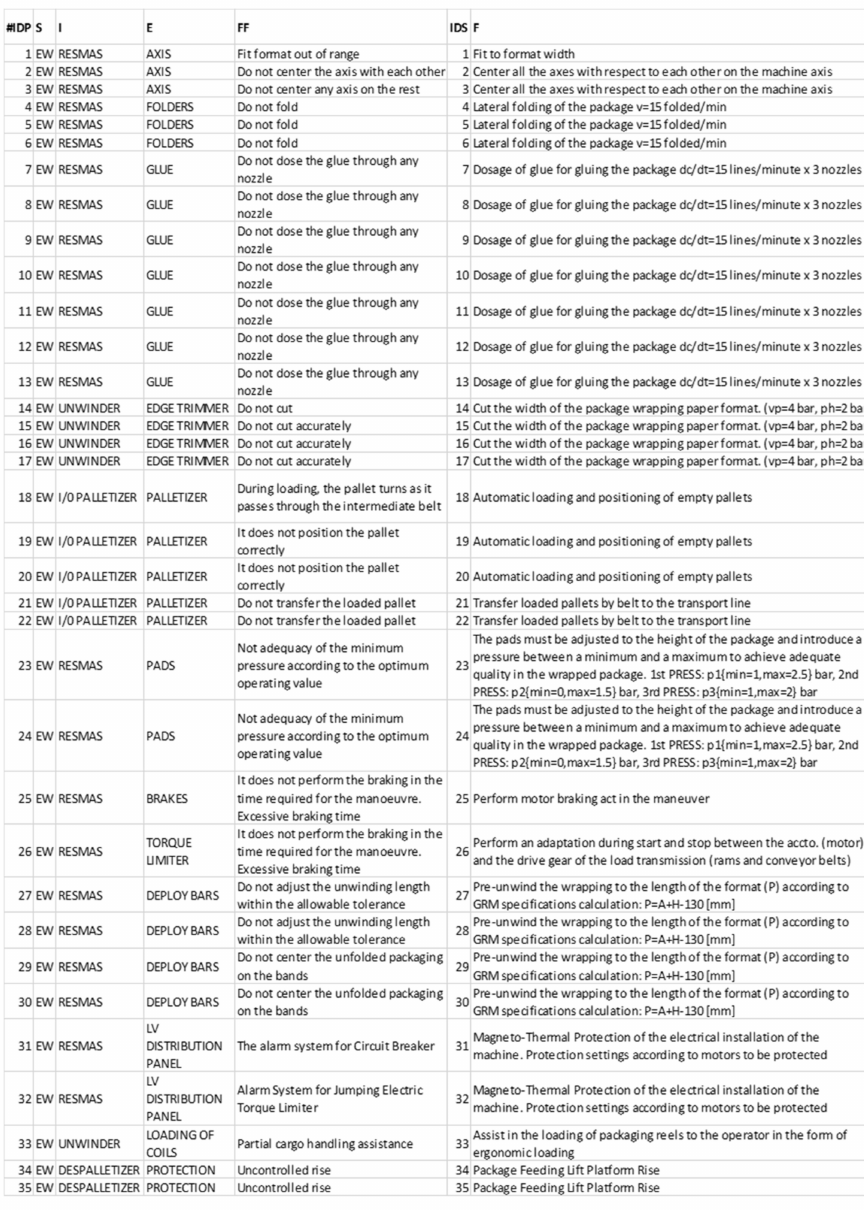
Figure 4. Records of the CSV file that make up the Case Base. Attributes {IDP}. Table 1. Attributes of the Case Base. CSV Database File Column